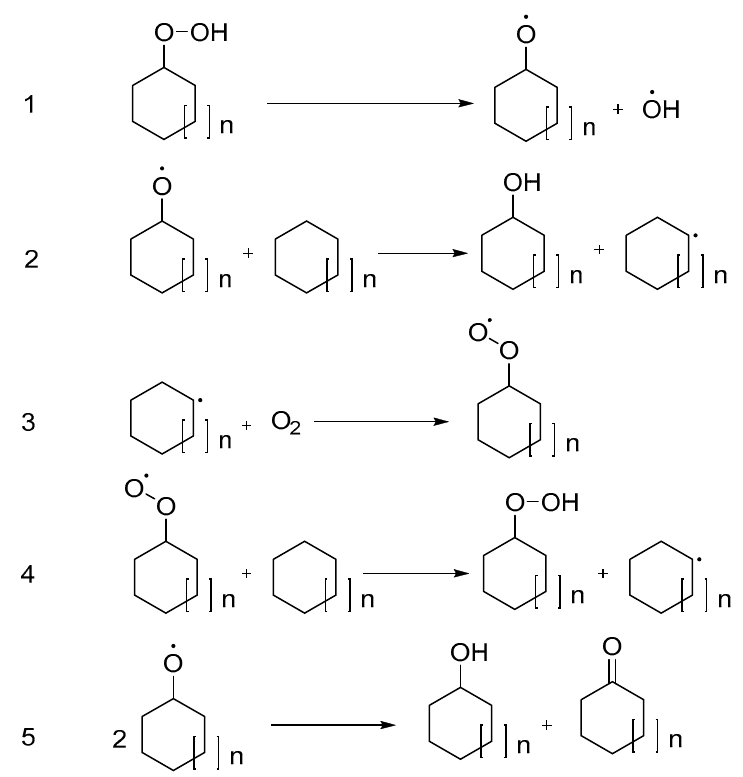
Table 2. Catalytic activity of catalysts for the oxidation of a